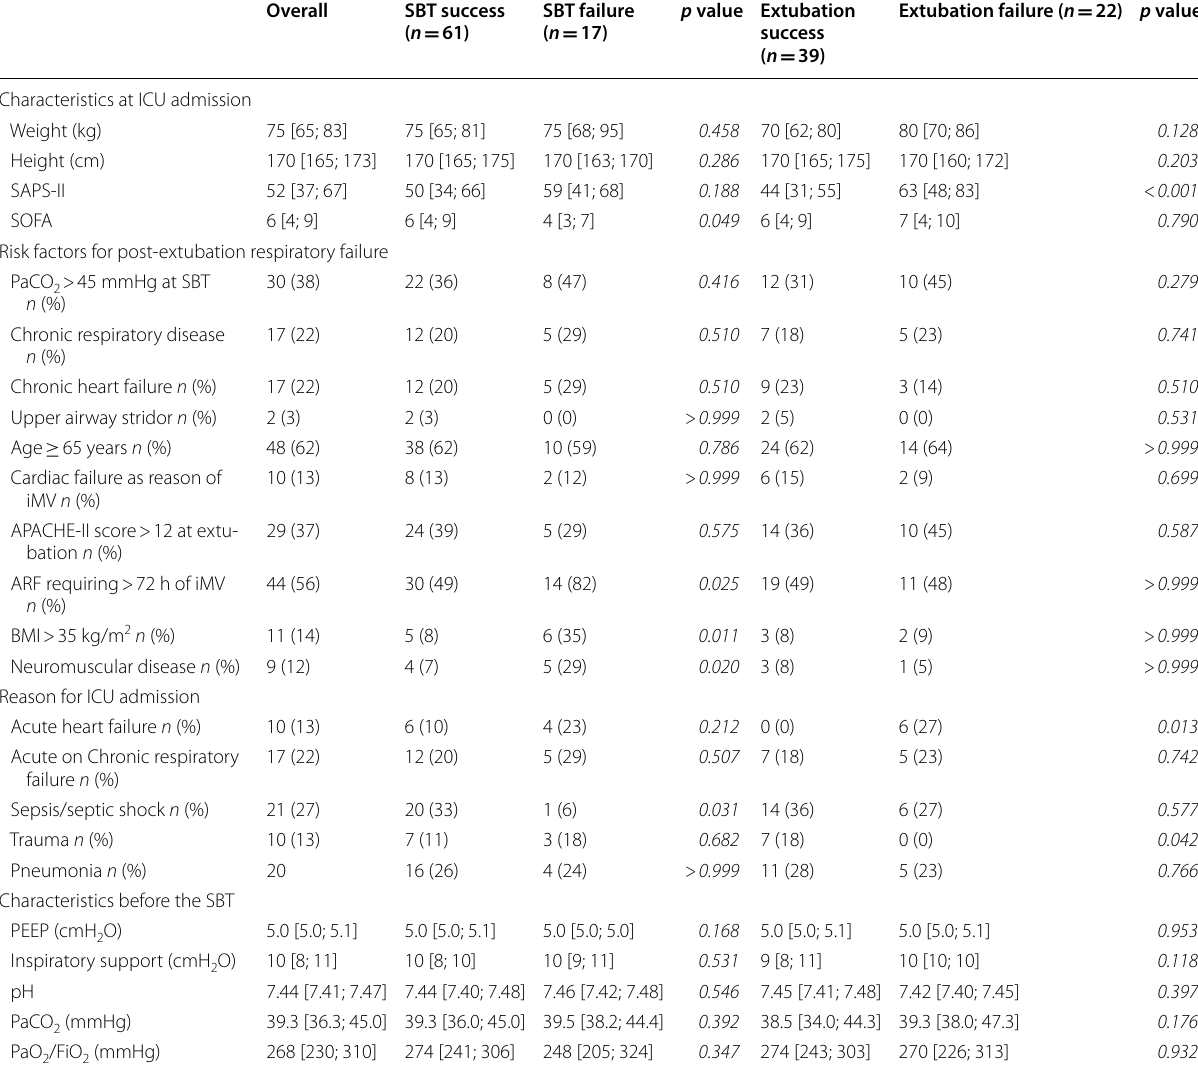
Table 1 Patient’s characteristics at ICU admission, risk factors for post-extubation respiratory failure, the reason for ICU admission and characteristics before SBT performance in the overall population and